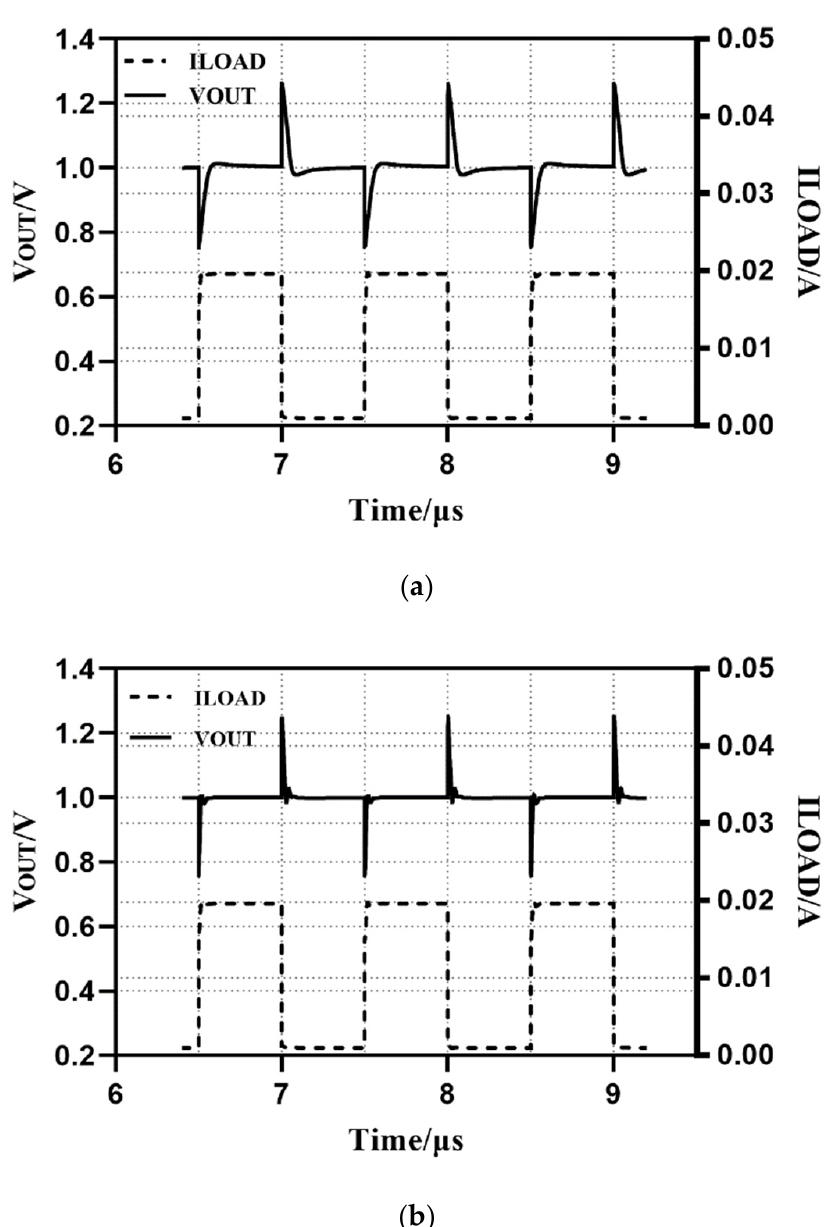
Figure 11. Transient response: ( a ) Without dynamic bias circuit; ( b ) With dynamic bias circuit. T settle is the recovery time when V OUT settles back to 1% accuracy [33]. As shown in Figure 11, the undershoot, overshoot and recovery time of the LDO without the proposed dynamic bias circuit were about 248 mV, 260 mV and 177 ns, respectively, while those of the LDO with the proposed circuit were about 242 mV, 250 mV and 52 ns only, respectively. The transient benefitted from the dynamic bias current and large bias current. Figure 12 shows the simulated recovery time versus process corners and temperature variations. As can be seen, across all process corners at − 40 ◦ C, 27 ◦ C and 85 ◦ C, the max recovery time was 59 ns at 85 ◦ C in the SS corner, while the min recovery time was 45 ns at − 40 ◦ C in the FF